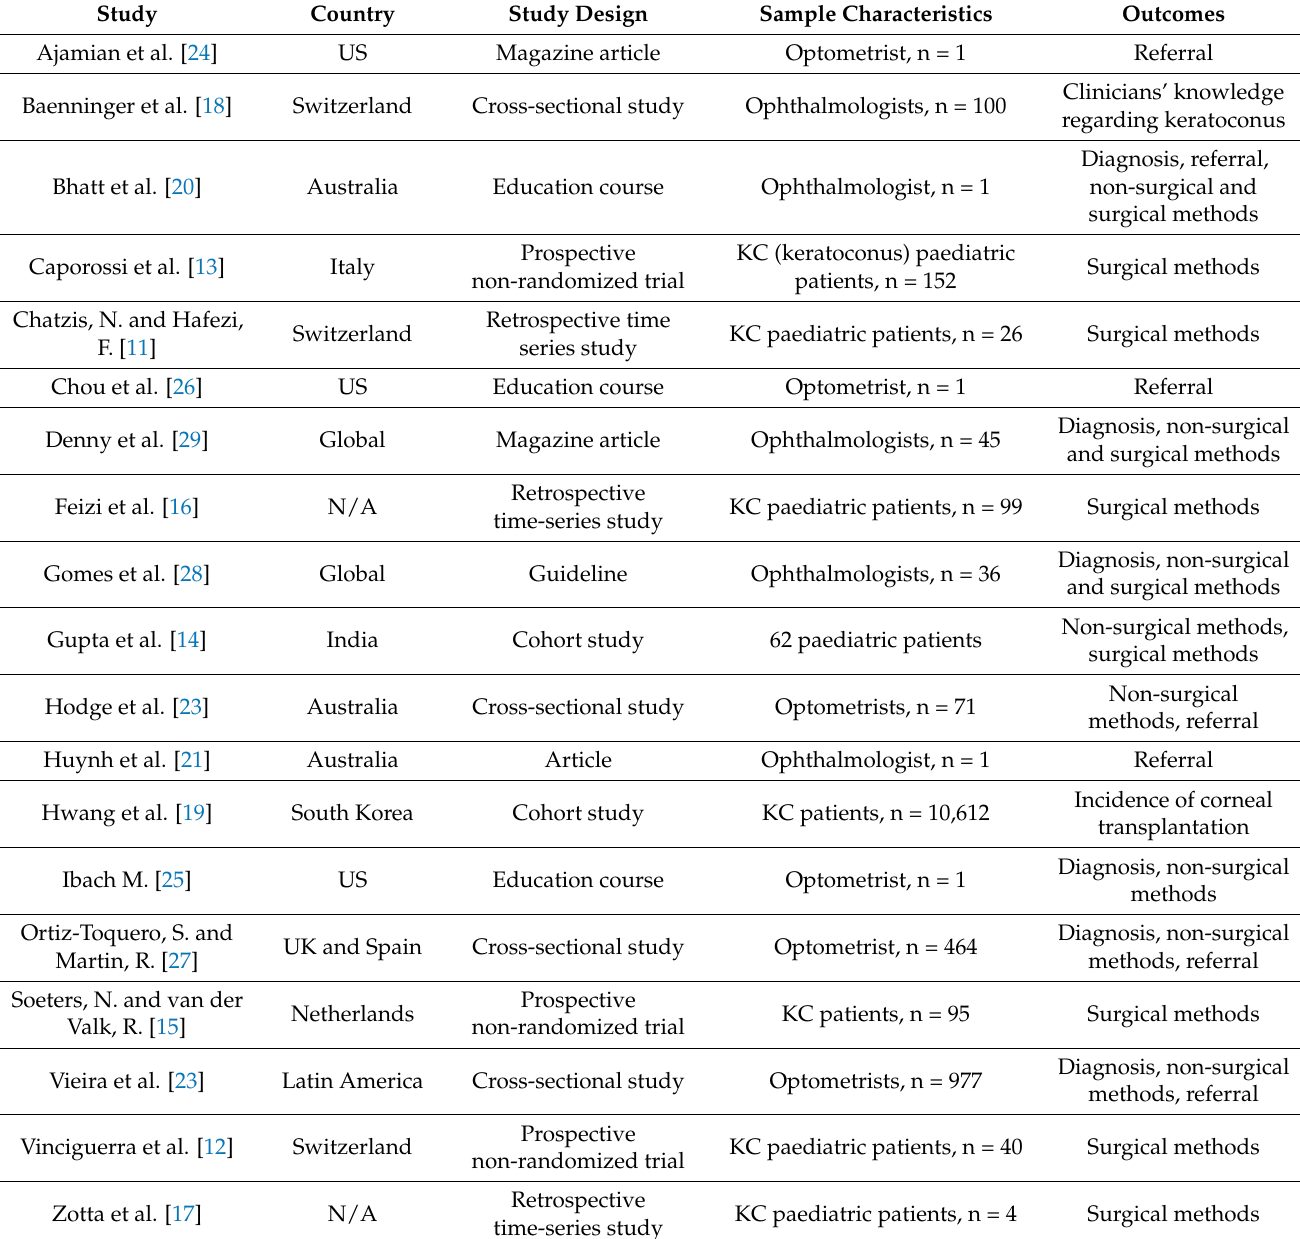
Table 1. Main characteristics of included